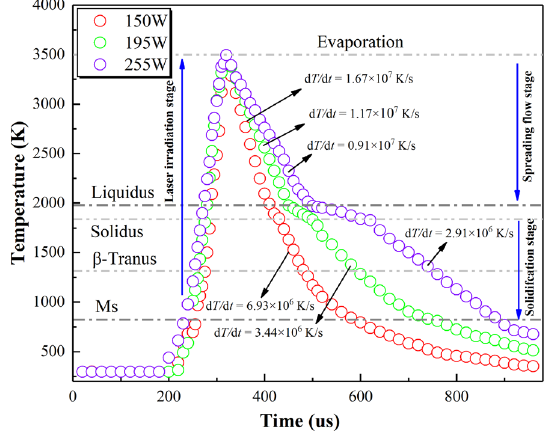
Figure 14 Thermal monitored at the cross-sections of LPBF tracks under different laser powers,